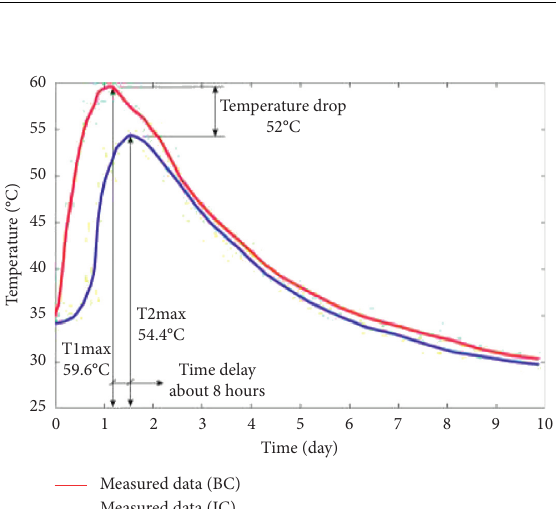
Figure 21: Temperature duration curve of reference concrete and inspected concrete at center point of side wall.